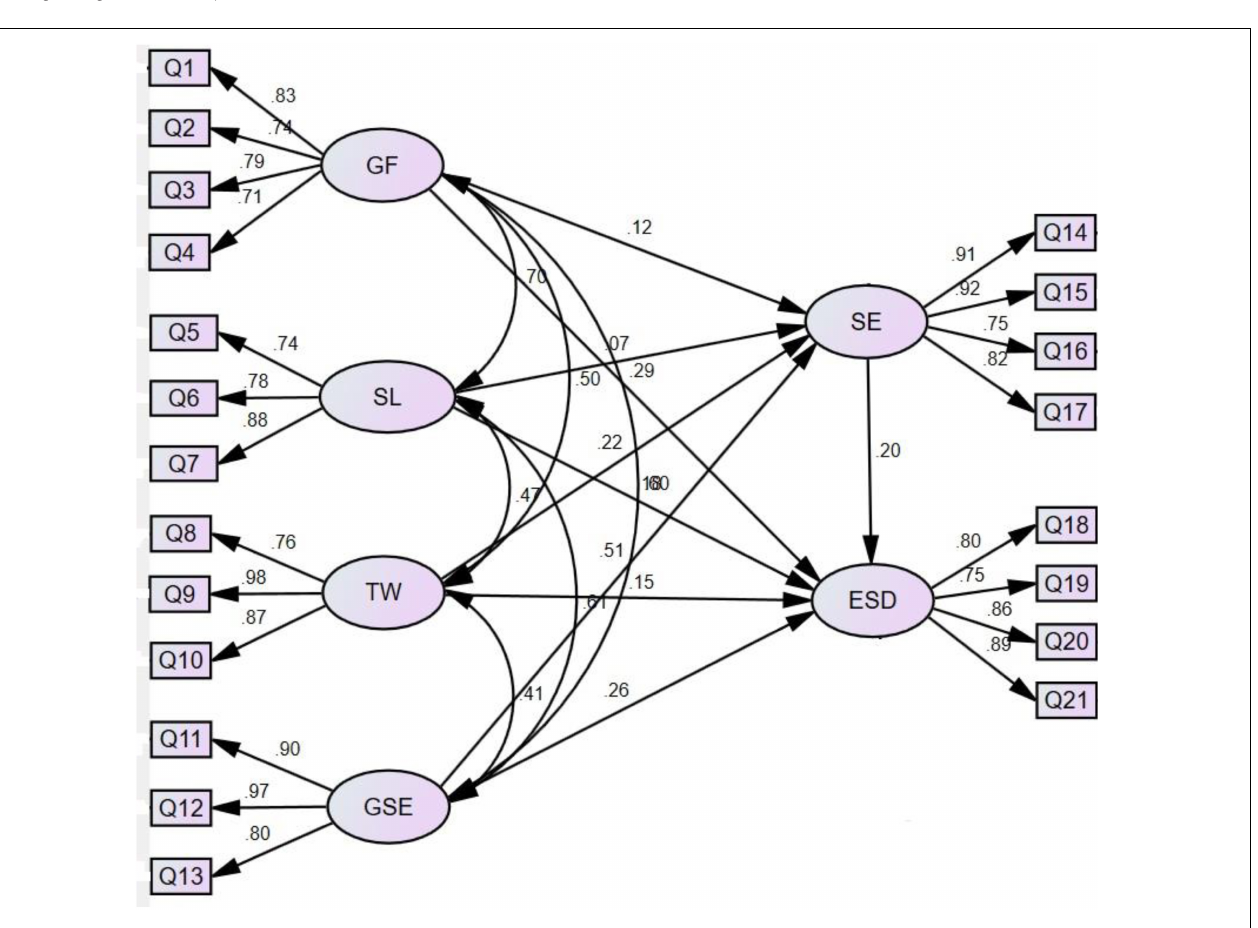
FIGURE 1 | Path analysis